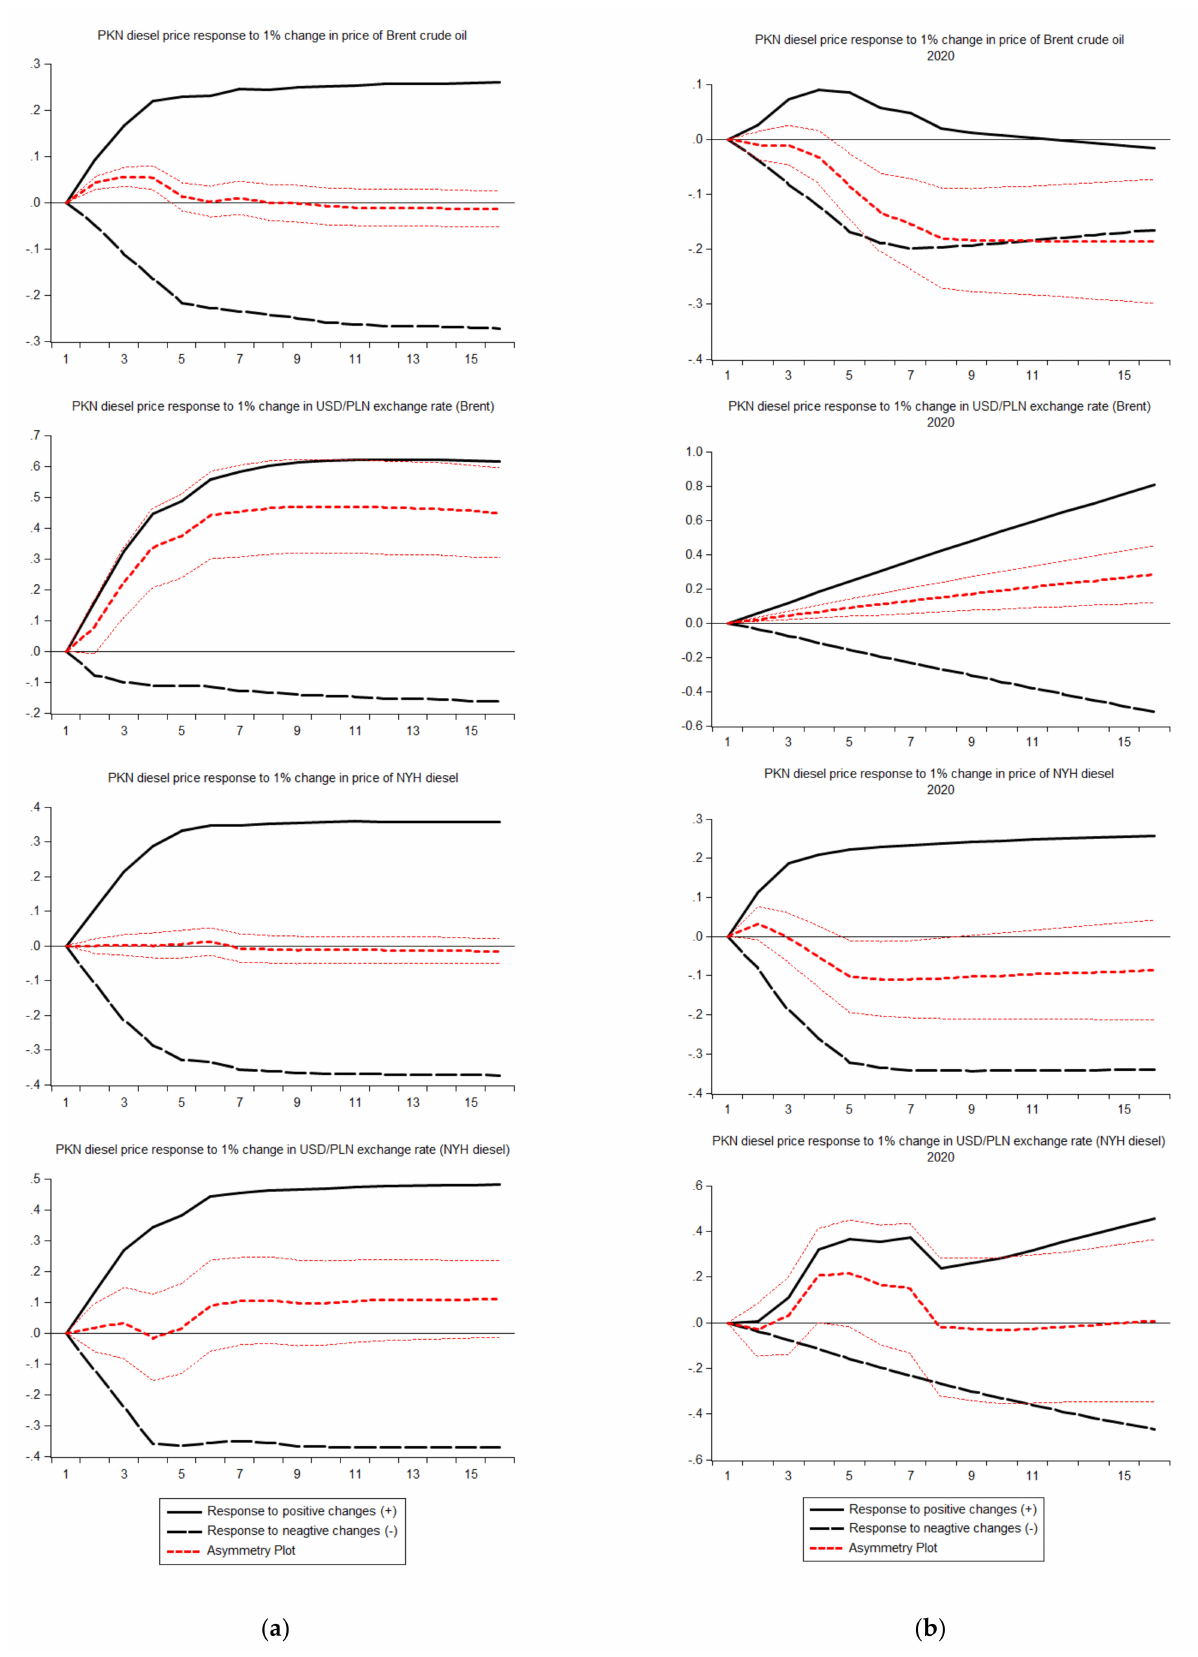
Figure 12. Dynamic multipliers for PKN Orlen Diesel ( a ) whole sample; ( b ) year